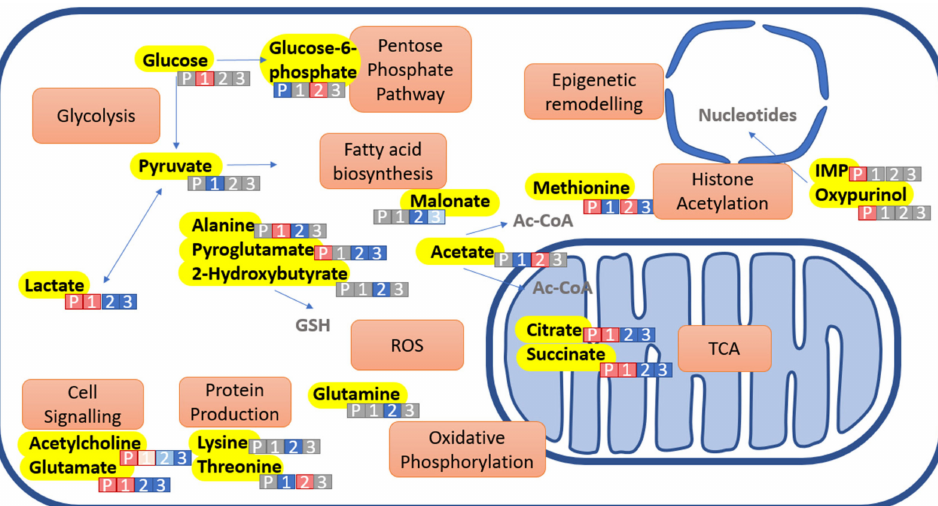
Figure 5. Intracellular metabolite changes between hIPSC, and stages 1, 2 and 3 directed differentia- tion. Metabolites highlighted yellow are selected metabolite changes observed. Metabolic processes associated are highlighted orange. White lettered/numbered boxes indicate the stage of differen- tiation (1, 2 or 3) or pluripotent IPSC indicated by ‘P’. Boxes are shaded to indicate the metabolite level at that stage—grey indicates a median value, red indicates an increased level and blue indicates lower level. Molecules in grey text are not observed in this study but are associated. Abbreviations used: GSH, Glutathione; ROS, reactive oxidative species; TCA, tricarboxylic acid cycle; IMP inosine,